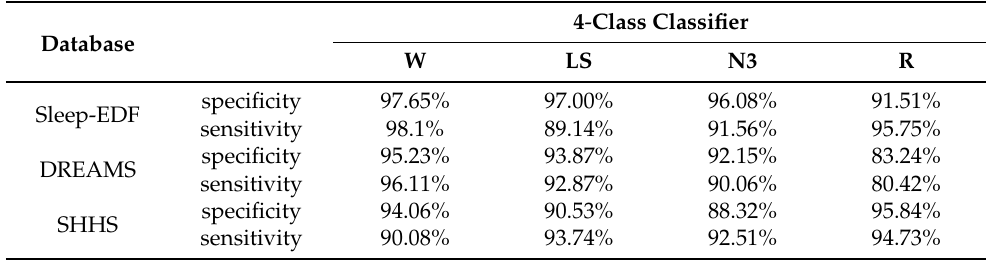
Table 4. The sensitivity and specificity of 4-class